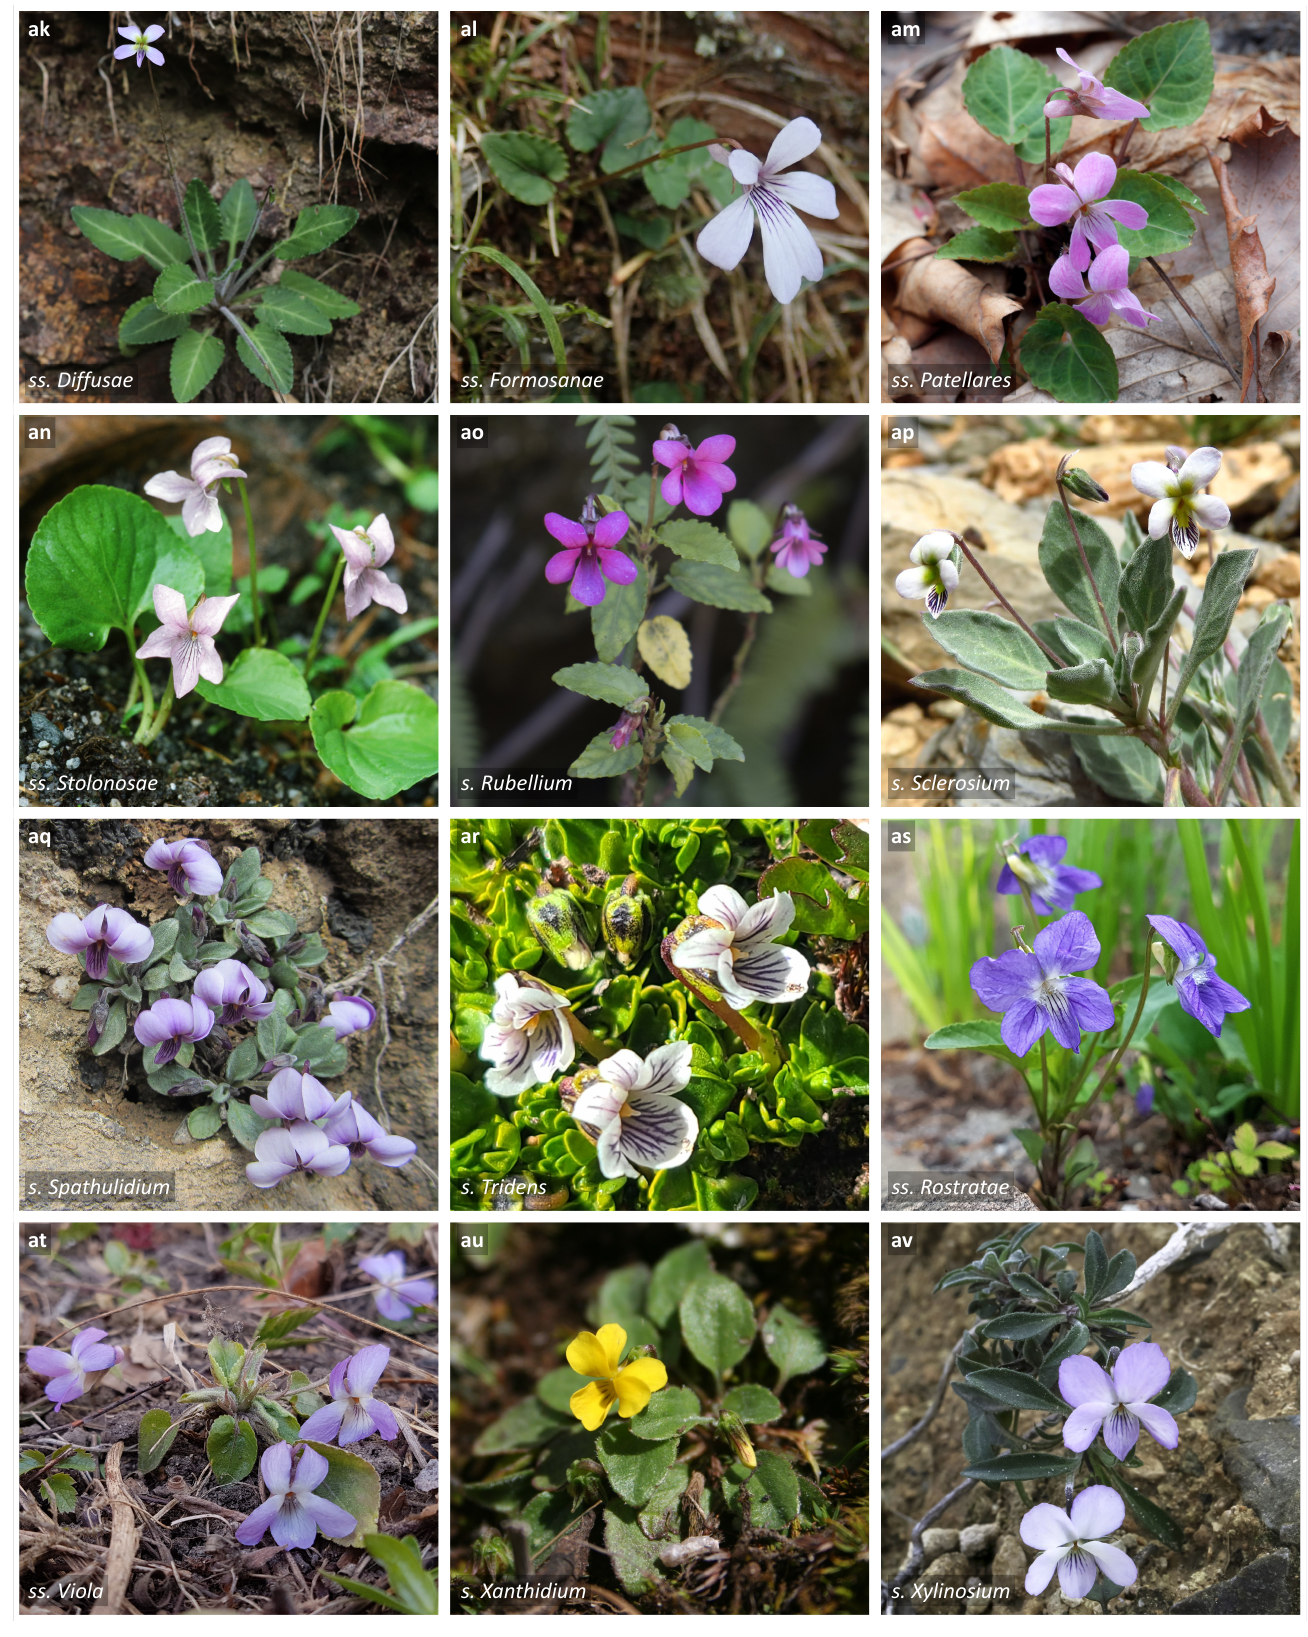
Figure 3. Photos of representative members of the sections and subsections of Viola .—( a – l ) Subg. Neoandinium .—( m – av ) Subg. Viola .—( a ) Sect. Confertae : V. nassauvioides .—( b ) Sect. Ericoidium